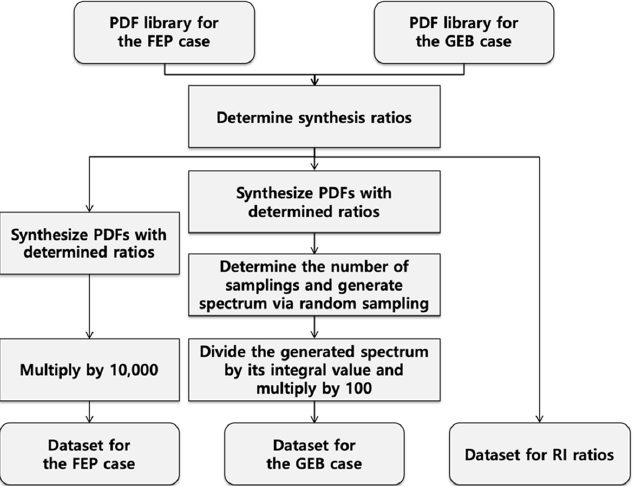
Figure 3. Dataset generation flowchart. By iterating the entire procedure 200,000 times, 200,000 spectra for the Gaussian energy-broadening (GEB) case, 200,000 spectra for the full-energy peaks (FEP) case, and 200,000 relative ratios were generated and used as a dataset.